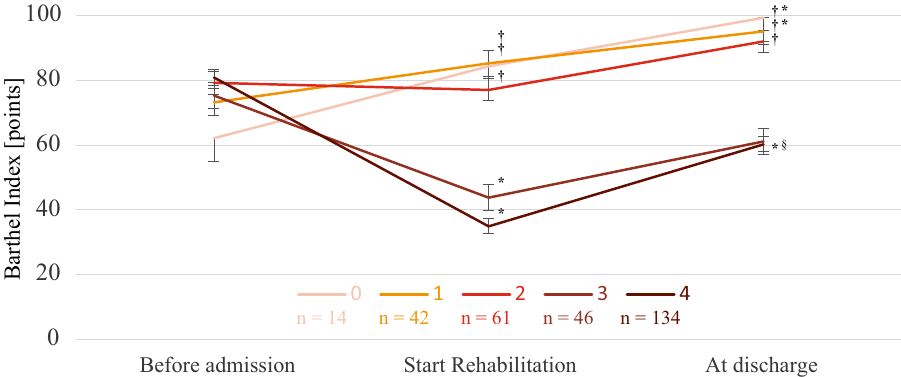
Figure 2. Association between overlapping muscle dysfunctions and the ability to perform activities of daily living. The number of subjects in each group is indicated by “n”. * There was a significant difference in the ADLs before and after admission ( p < 0.05). †There was a significant difference in the ADLs between 3 or more and less than 3 with overlapping muscle dysfunctions ( p < 0.05). § There was a significant difference in the ADLs before and after inpatient rehabilitation ( p < 0.05). ADLs, activities of daily living.